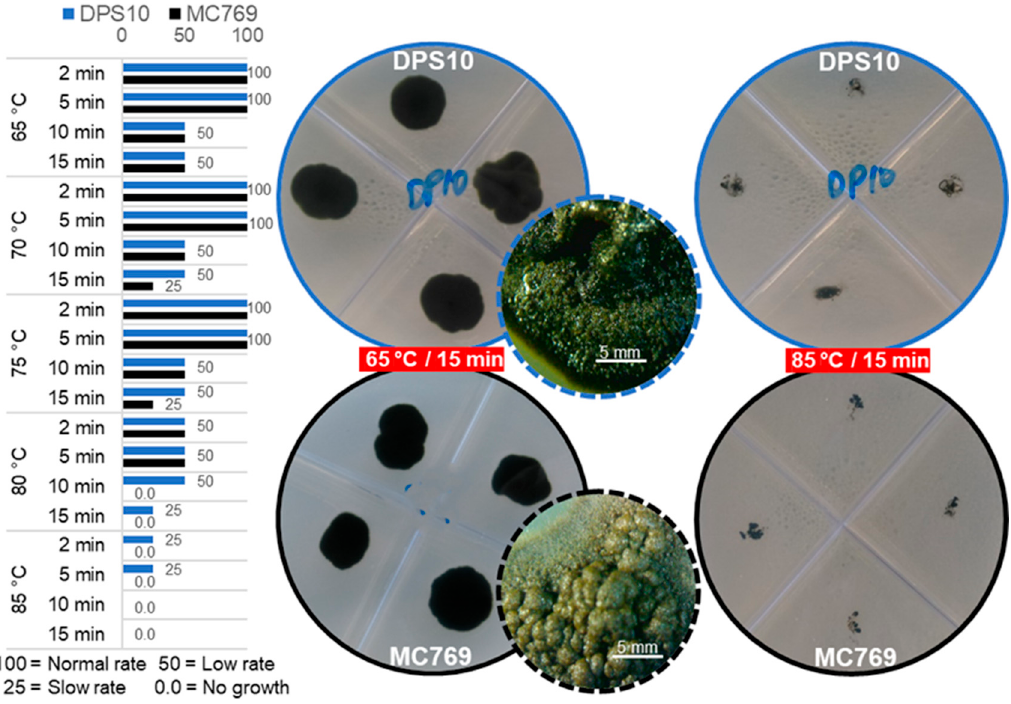
Figure 7. Heat stress tolerance examination of Pseudotaeniolina globosa DPS10 and MC769 isolates. Column chart on the left exhibits comparison of DPS10 and MC769 isolates growth monitored on PDA media after 2, 5, 10, and 15 min at 65, 70, 75, 80, and 85 °C; the x ‐ axis represents the grade from 100 for regular growth rate after one month of incubation (21.0 and 25.0 mm colony diameter for DSP10 and MC769, respectively) to 0.0 for no growth. Visual examination of the cultured plates on the right shows the growth of DPS10 and MC769 at 65 and 85 °C after 15 min of heat exposure, with a stereomicroscopic focus for one of the grown colonies (bar = 5 mm). Table 2. List of Pseudotaeniolina globosa available accession numbers in the GenBank database with an indication of the literature reference where they were